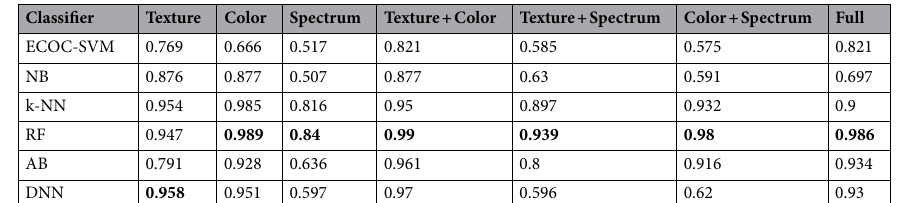
Table 3. Results of features-based psoriasis severity classification in Dataset B. The bold values indicate the best results. It shows the F1-score comparison for the six classifiers performance according to the combination features. We created likewise several combinations using texture, color, and spectrum, and Full is the case of using all features.